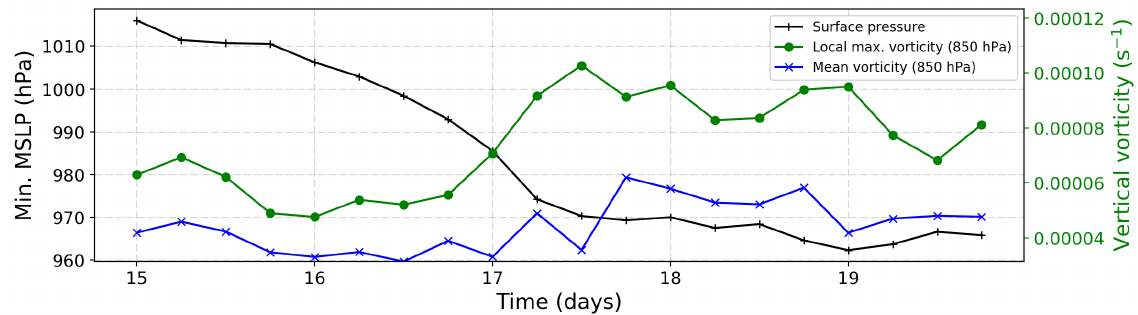
Figure 3. Minimum of mean sea level pressure (MSLP) observed inside Kyrill’s area (black line) and mean vorticity ζ averaged over Kyrill’s area (blue line), as well as local maximum vorticity observed inside the area. Properties derived from NCEP